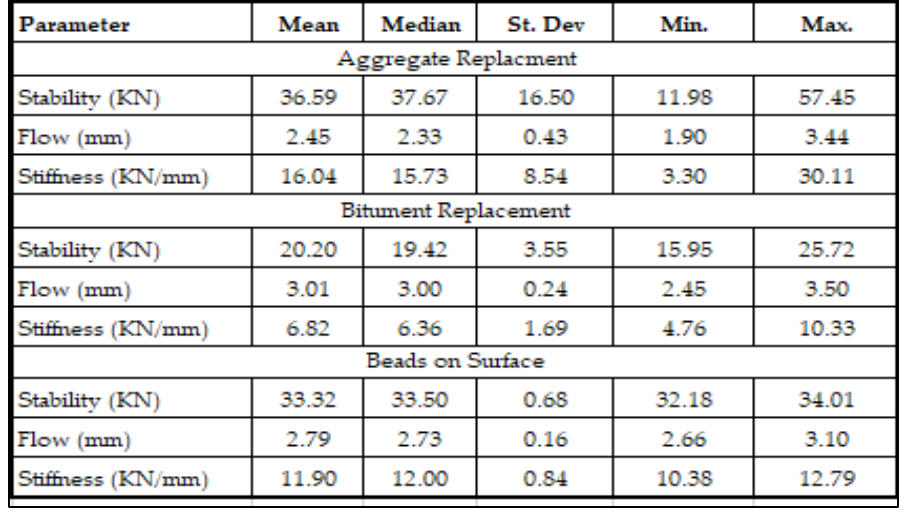
Figure 6 . Statistical data description of performance properties of asphalt concrete mix. Figure 6. Statistical data description of performance properties of asphalt concrete